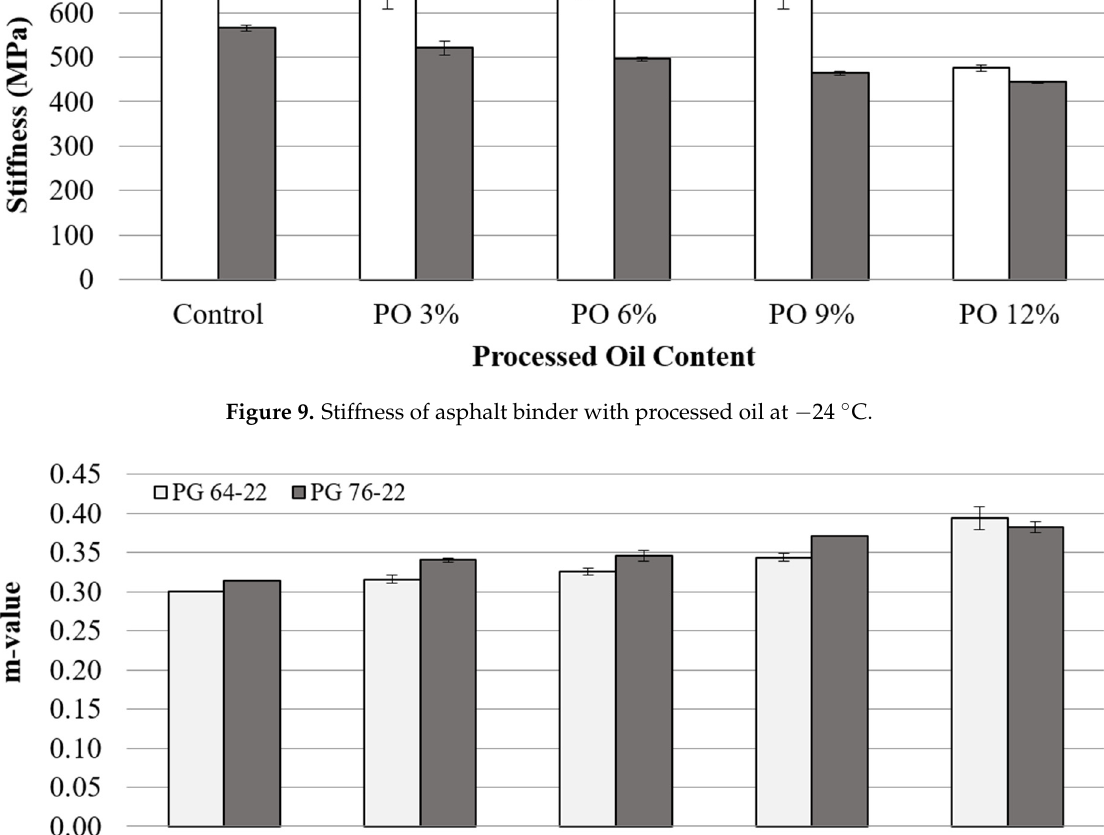
Figure 11. m ‐ value of asphalt binder with processed oil at − 24 °C. The statistical analysis of changes in stiffness as a function of processed oil content at temperatures of − 12 °C and − 24 °C is shown in Tables 8 and 9, respectively. In general, asphalt modification resulted in a significant difference at a temperature of − 12 °C. How ‐ ever, insignificant differences were observed for each oil content at a temperature of − 24 °C. This indicates that processed oil is not statistically effective for improving cracking resistance at − 24 °C compared to the results at − 12 °C. Table 8. Statistical analysis results of the stiffness as a function of processed oil content at − 12 °C (  = 0.05). Stiffness